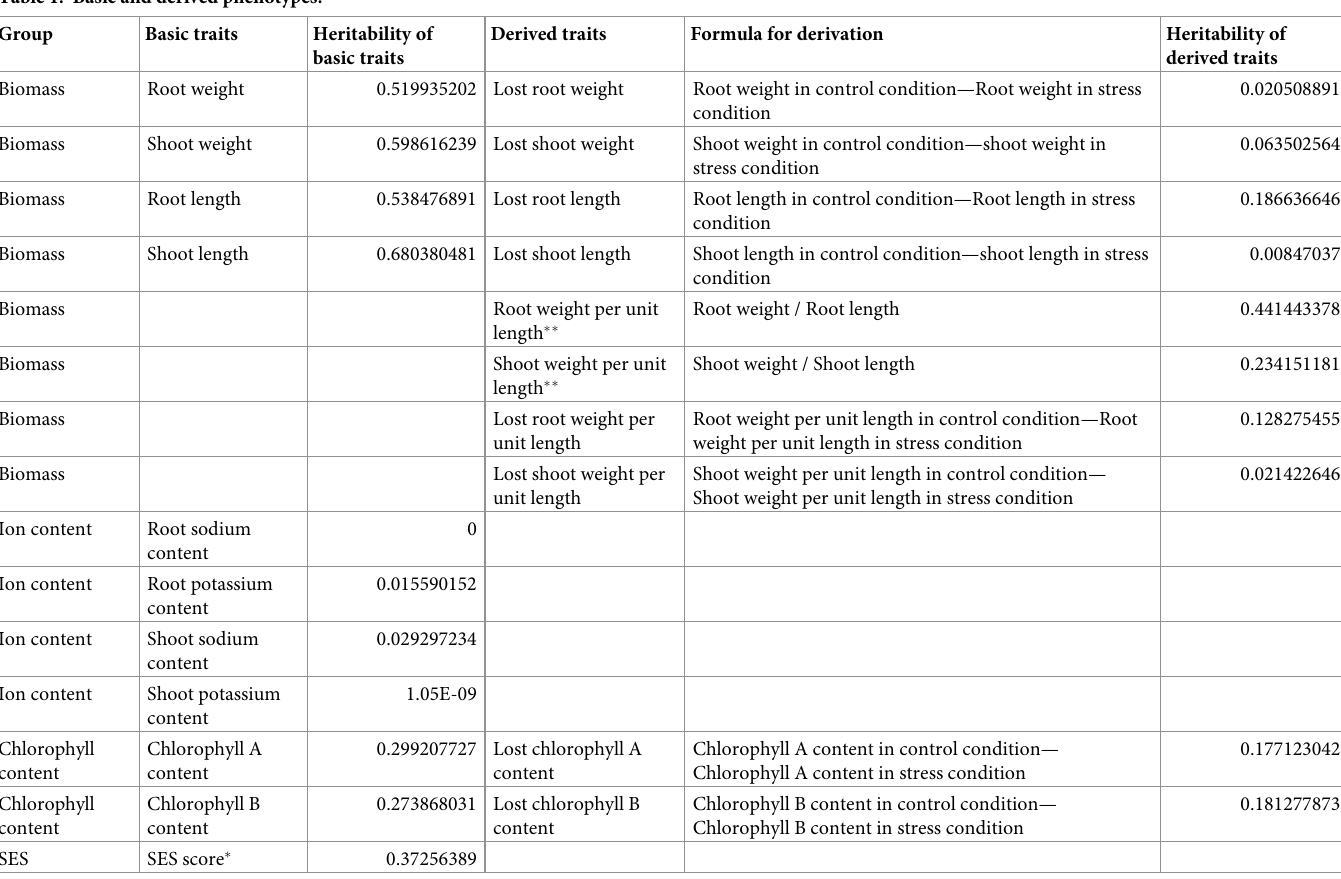
Table 1. Basic and derived